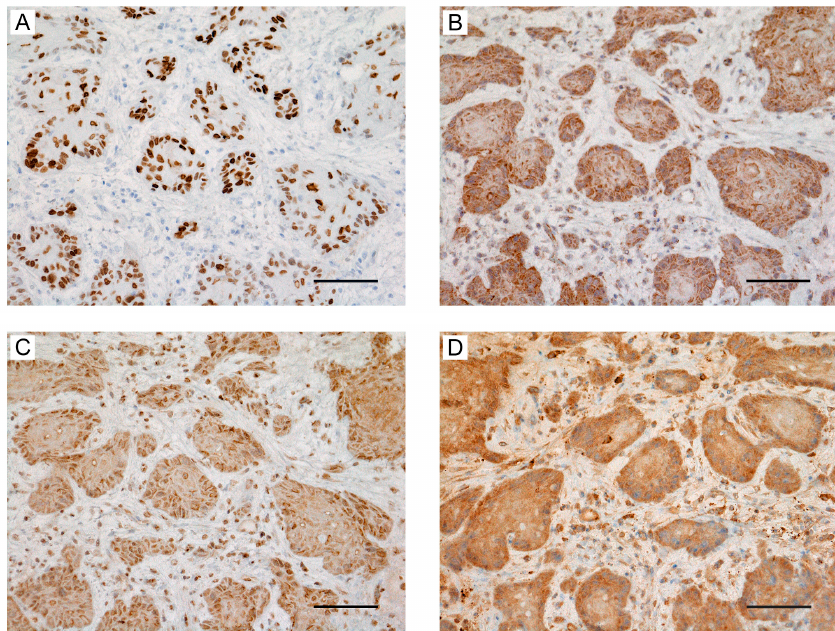
Figure 4. High expression of angiogenesis-associated genes in oral squamous cell carcinoma (OSCC) tissues based on HMGA2 expression. Images of immunohistochemical staining based on the following antibodies in OSCC biopsy specimens: ( A ) HMGA2, ( B ) VEGF-A, ( C ) VEGF-C, and ( D ) FGF-2. Scale bar, 100 µ m.